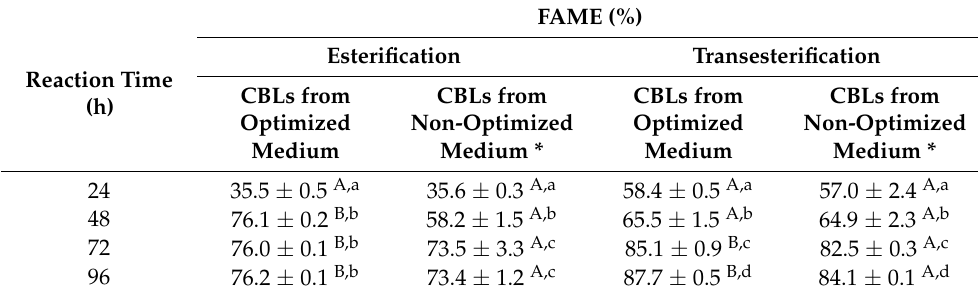
Values are presented as mean ± SD (n = 3), Different superscript uppercase letters in the same row indicate significant differences ( p < 0.05), Different superscript lowercase letters in the same column indicate significant differences ( p < 0.05), * Data obtained from the previous study